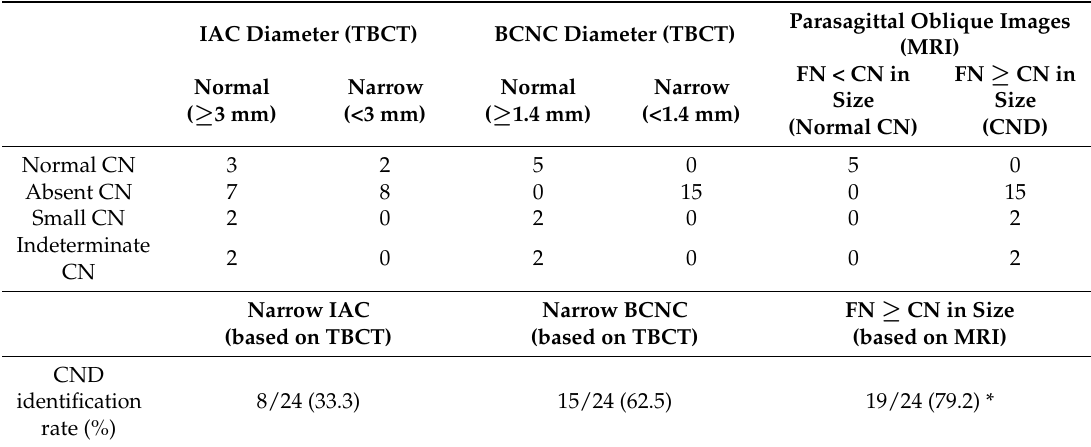
Table 3. CND identification rate via the estimation from the presence of narrow IAC and narrow BCNC as well as FN-CN size optical comparison in combination with baseline